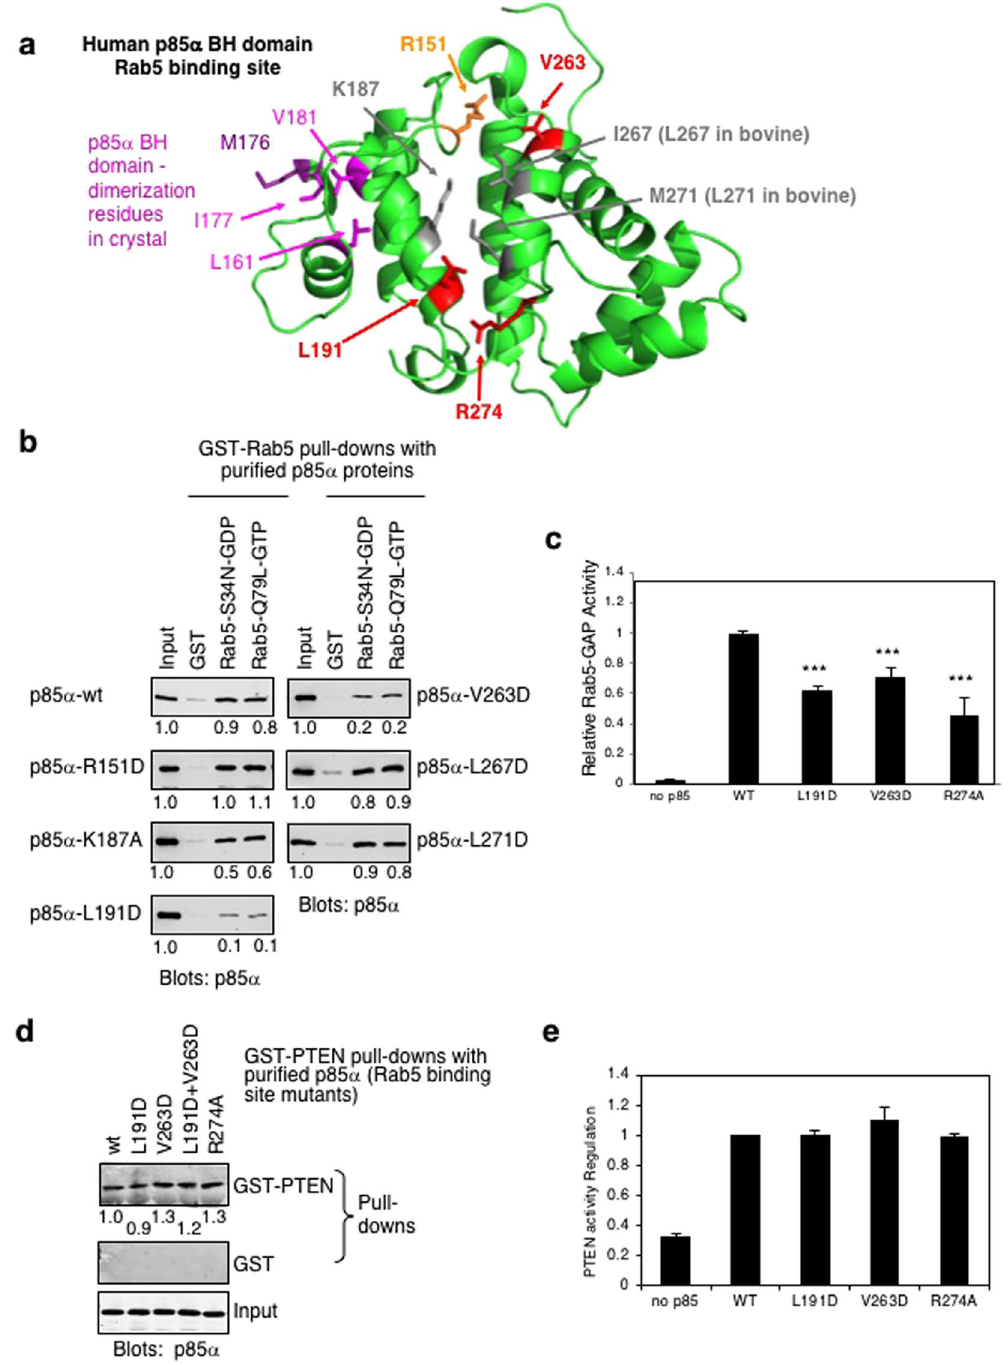
Figure 4. Residues L191 and V263 in the p85 α BH domain are important for Rab5 binding. ( a ) The BH domain of human p85 α with the proposed G protein binding (i.e. Rab5) residues indicated. Residues with little or no effect on Rab5 binding are shown in grey (K187, I267 [L267 in bovine p85 α ], M271 [L271 in bovine p85 α ]), with catalytically important R151 in orange. Residues important for both Rab5 binding and catalytic activity are shown in red (L191, V263, R274). Residues that help mediate BH–BH domain dimerization within the crystal structure are shown in M176 (purple) from one BH domain fitting into a hydrophobic pocket containing L161, I177 and V181 (pink) on the other BH domain 29 . ( b ) Pull-down assay with GST and GST- Rab5 mutants immobilized on glutathione Sepharose beads and loaded with the indicated nucleotide. Binding of purified p85 α wild type or mutant protein was detected using an immunoblot analysis. The input lanes contain 0.4% of the purified p85 α protein used in the pull-down assay. Full-length images of the cropped blots are in Supplementary Fig. S6. ( c ) The ability of each p85 α mutant protein to regulate Rab5 GTPase activity was determined using a Rab5 GAP assay. Mean ± SEM from three independent experiments. *** P < 0.001 as compared to wild type p85 α . ( d ) Immobilized GST and wild type GST-PTEN were allowed to bind